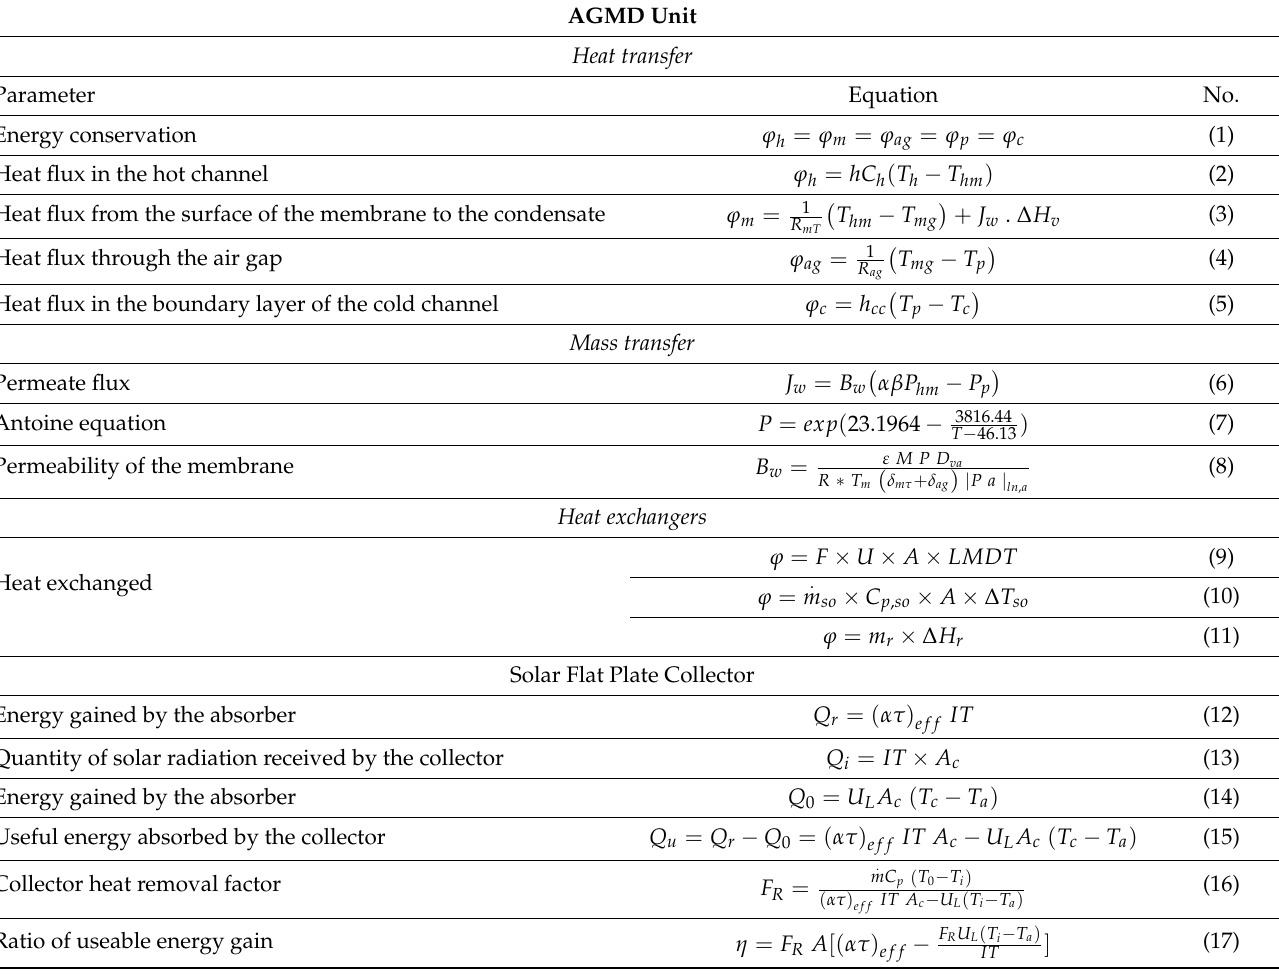
Table 2. Mass and energy balance model equations